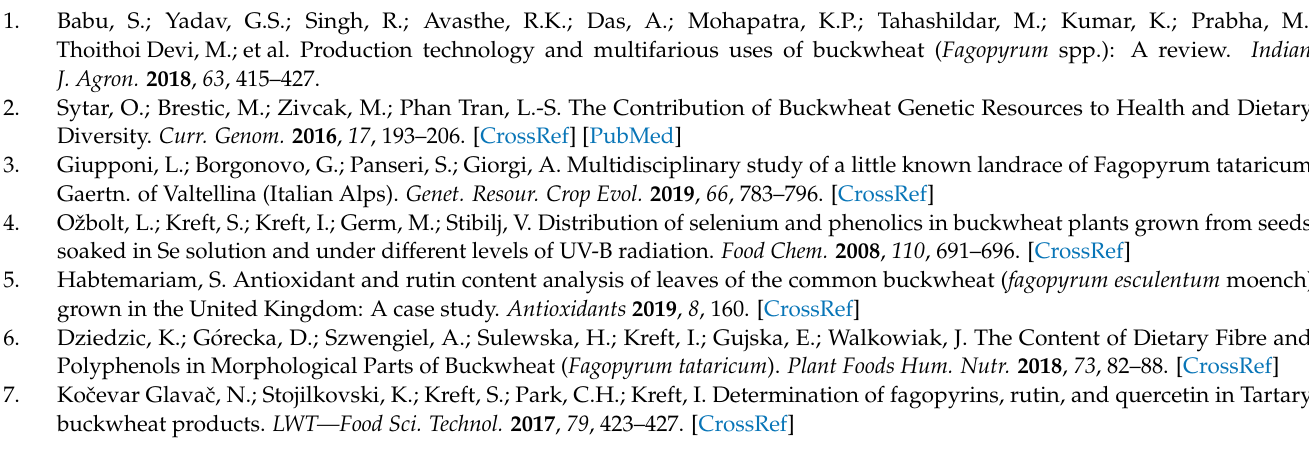
Figure S5. HOMO (left) and LUMO (right) orbitals for the 25, 26, 27, 28, 29, and 30 Fagopyrin E conformers. Figure S6. The shape of the orbitals for structure 31 (Fagopyrin F). 176—HOMO and 177—LUMO orbitals. Figure S7. The shape of the orbitals for structure 33 (Fagopyrin F). 176—HOMO and 177—LUMO orbitals. Figure S8. The shape of the orbitals for structure 34 (Fagopyrin F). 176— HOMO and 177—LUMO orbitals. Figure S9. The shape of the orbitals for structure 35 (Fagopyrin F). 176—HOMO and 177—LUMO orbitals. Figure S10. The shape of the orbitals for structure 36 (Fagopyrin F). 176—HOMO and 177—LUMO